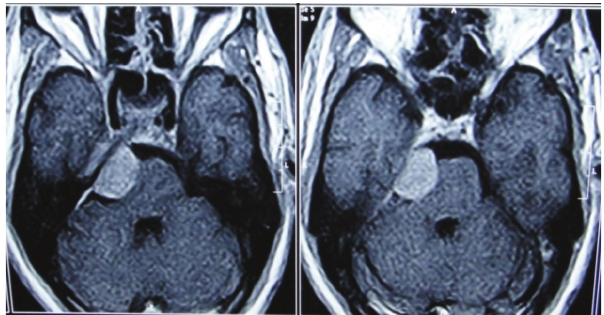
Figure 3: MRI T1W axial image with contrast shows well-defined intensity enhancing extra-axial mass lesion involving right cerebral pontine angle region. MRI impression: MRI study in contrast revealed possibility of CP angle Schwannoma or Meningioma.